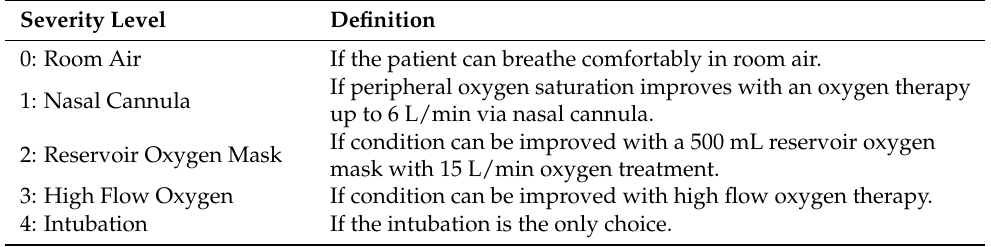
Table 2. Severity Levels of Patients Based on the Mode and the Quantity of Oxygen